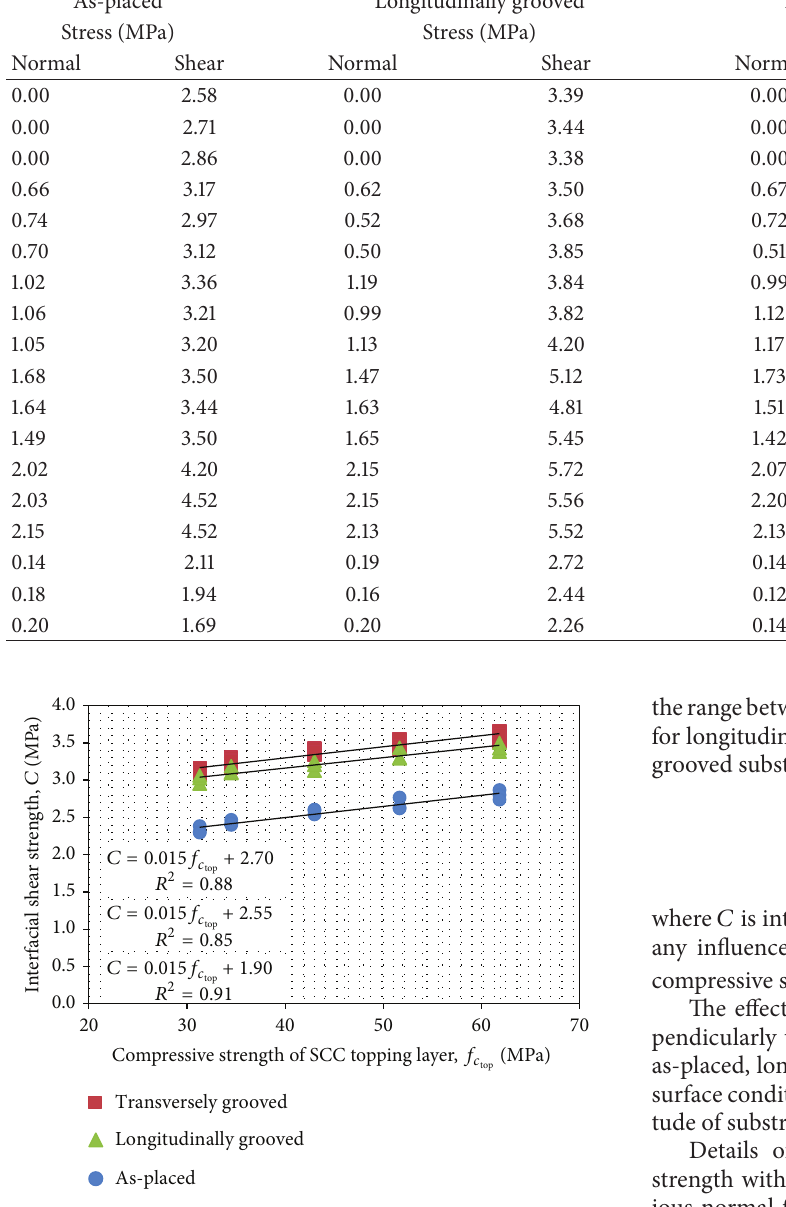
Figure 7: Effect of SCC topping layer compressive strength on the cohesion of interface with different substrate surface